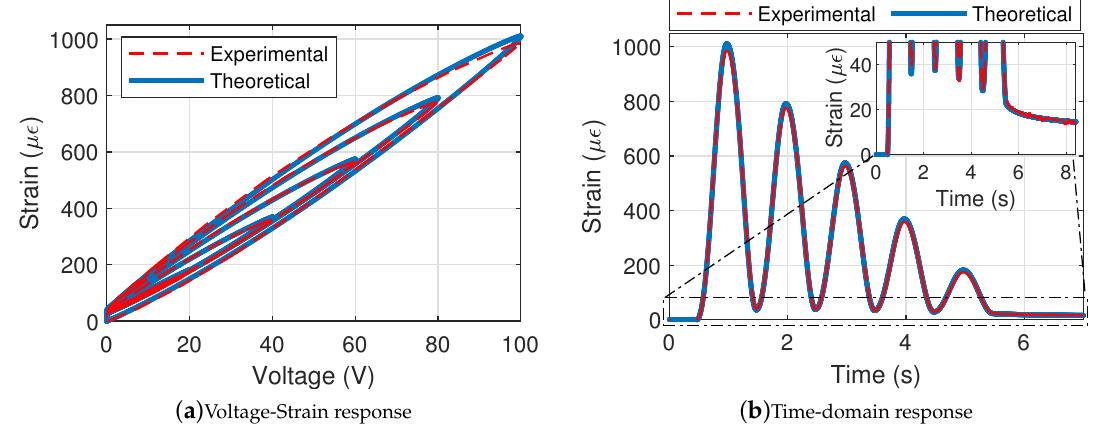
Figure 12. Experimental and predicted response for varying voltage